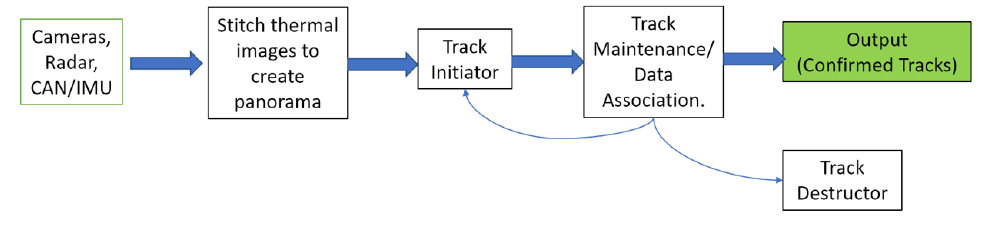
Figure 9. Overview of the object tracking